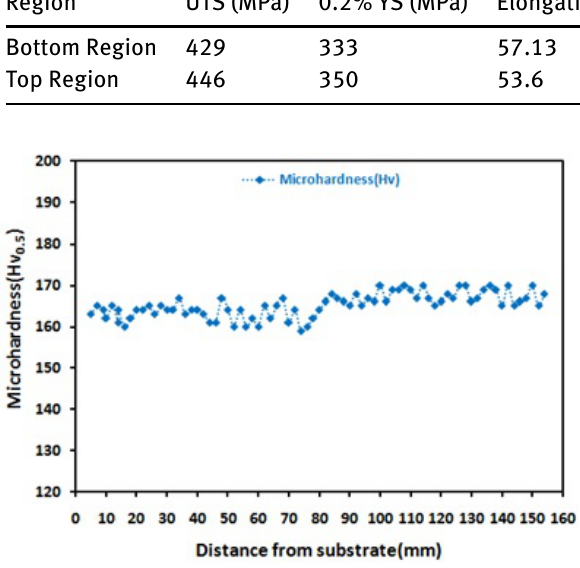
Figure 8: Vickers microhardness variations on the surface of the component along the building direction.